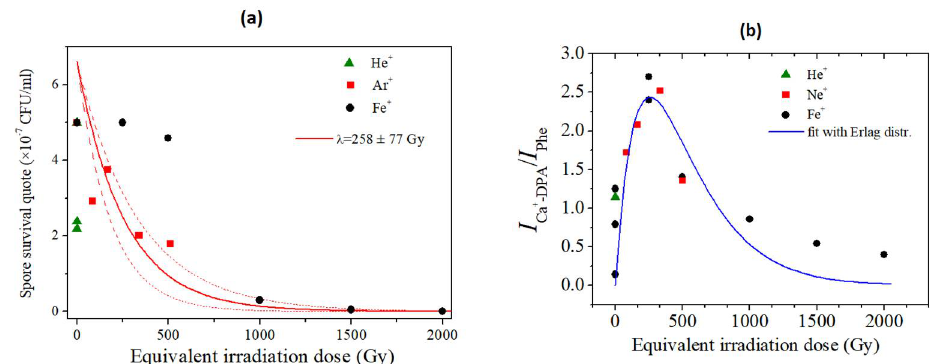
Figure 8. ( a ) Survival fraction of spores irradiated in a water solution (data from Figure 2): comparison of HZE efficacy. Equivalent doses refer to Fe. The exponential decay (red curve) is obtained from the Erlag distribution for k = 0 and λ = 258 ± 77 Gy (see Appendix B). The survival portion of spores is related to the zero-event probability of impact with ions. ( b ) SERS evaluation of the ratio I Ca2+-DPA /I Phe as a function of the equivalent irradiation dose Φ refers to Fe (data from Figure 5). This ratio is assumed to be proportional to the Ca 2+ -DPA leaked from spores. The experimental data have been fitted by the Erlag distribution curve, with fit parameters k = 1 and λ = 258 ± 77 Gy (see Appendix B). The germination is activated by a single event of ion